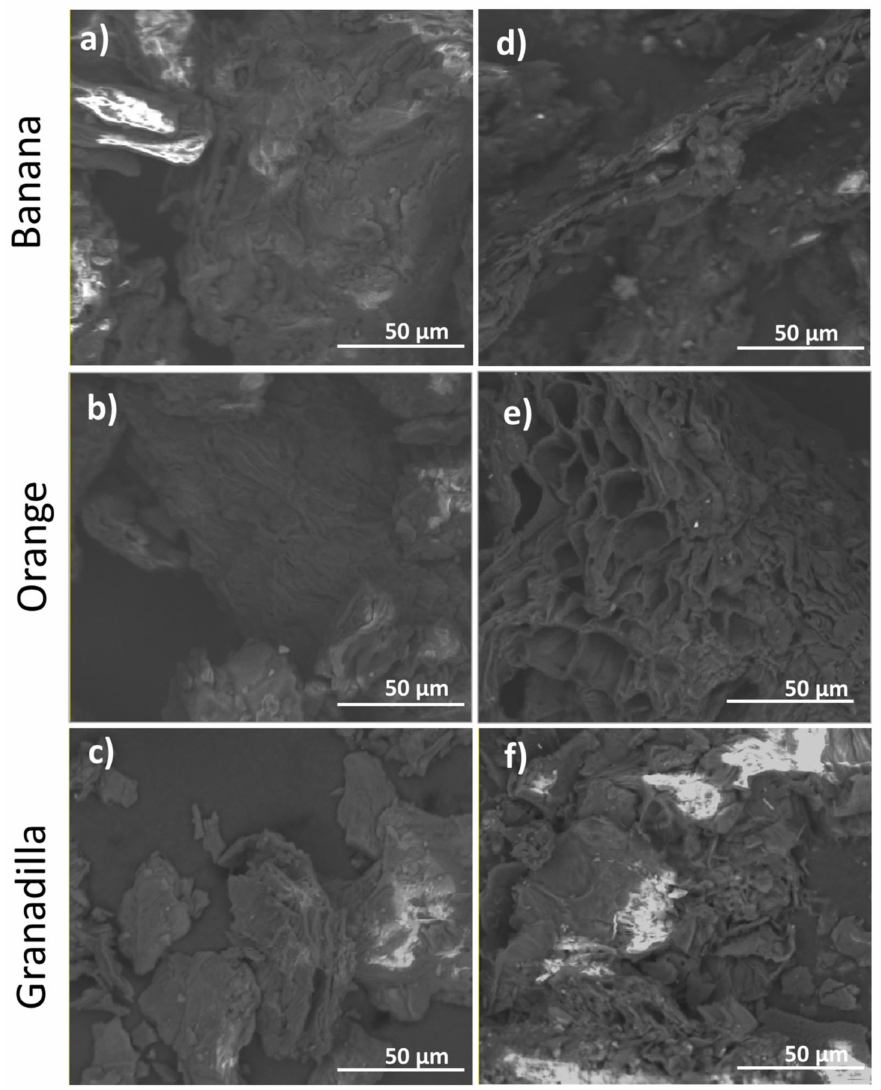
Figure 3. SEM micrographs of banana, orange, and granadilla peel adsorbents before ( a , b and c , respectively) and after the chemical treatment with 0.8 M modifiers ( d , e , and f ,